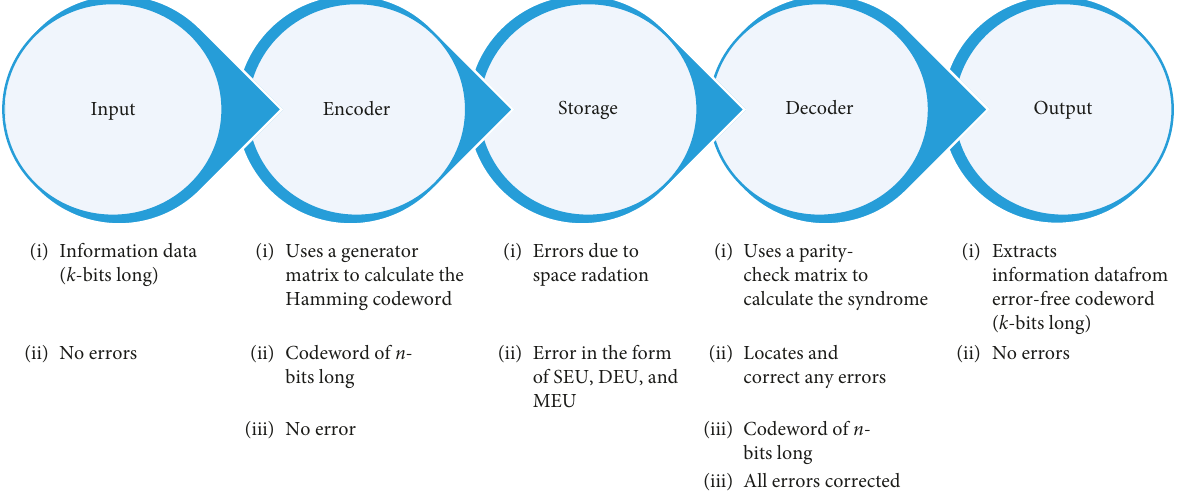
Figure 3: General layout of Hamming code. Table 4: Bit layout of Hamming code (nonsystematic).